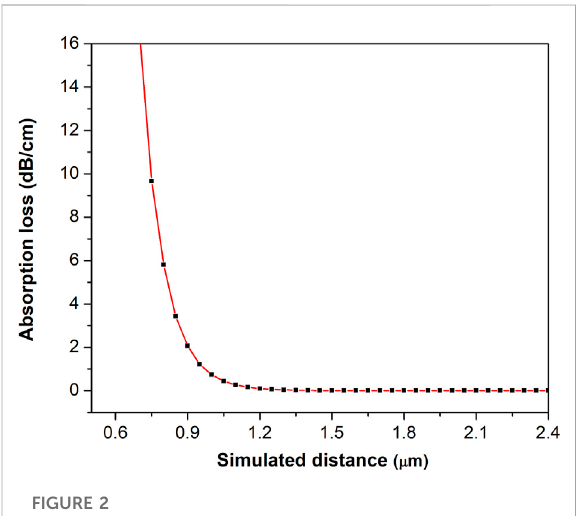
FIGURE 2 Simulated waveguide loss with varying silica thickness.